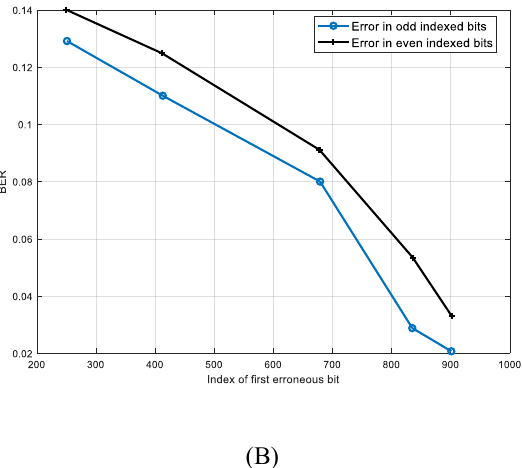
Figure 9 (A)The effect of error propagation on performance of polar codes under SC decoder at block length 2 10 over a BEC with erasure probability zero and rate 0.5. First error location is the index of the data for which wrong decision is made for the first time. Small error locations have more degrading effect. (B) The effect of first error location on performance of polar codes under SC decoder at block length 2 10 over a BEC with erasure probability zero and rate 0.5. Even locations have more degrading effects.